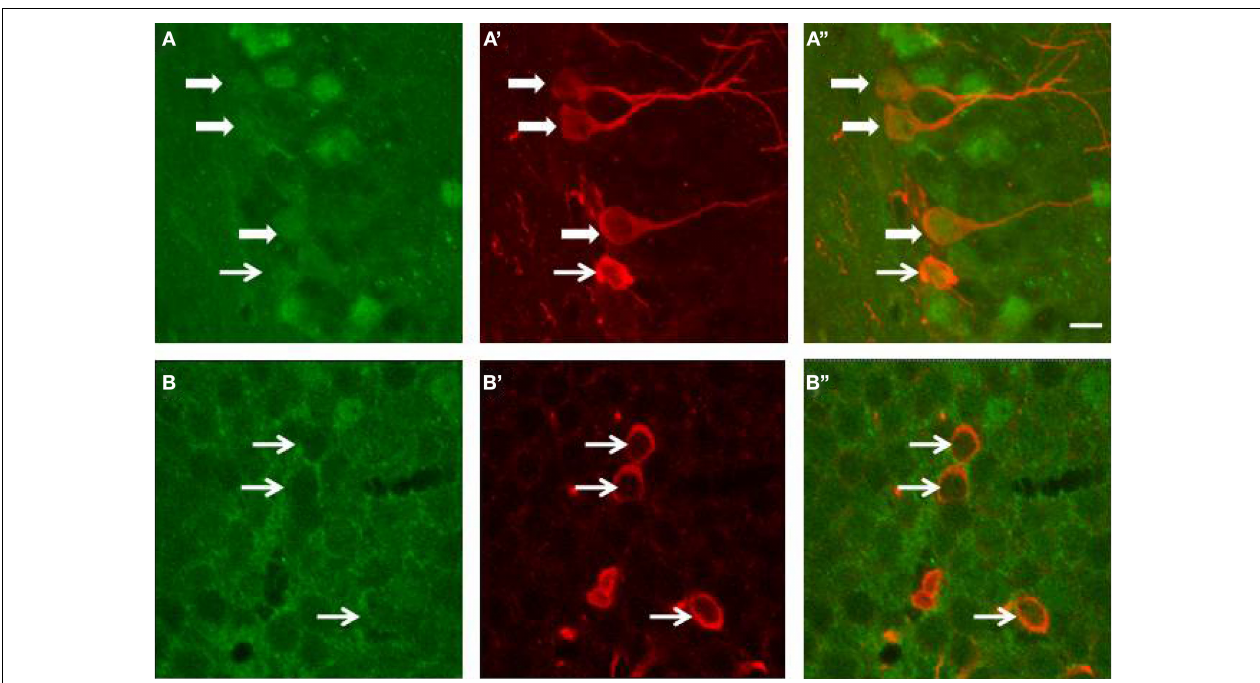
FIGURE 4 | Expression of TrkB receptors (green) by doublecortin (red)-labeled cells of the dentate gyrus of wild type mice. (A , B) TrkB expression; (A’ , B’) Doublecortin expression; (A”,B”) merge. White arrows point to doublecortin-immunoreactive cells (with or without processes) that express the TrkB receptors. The bar represents 8